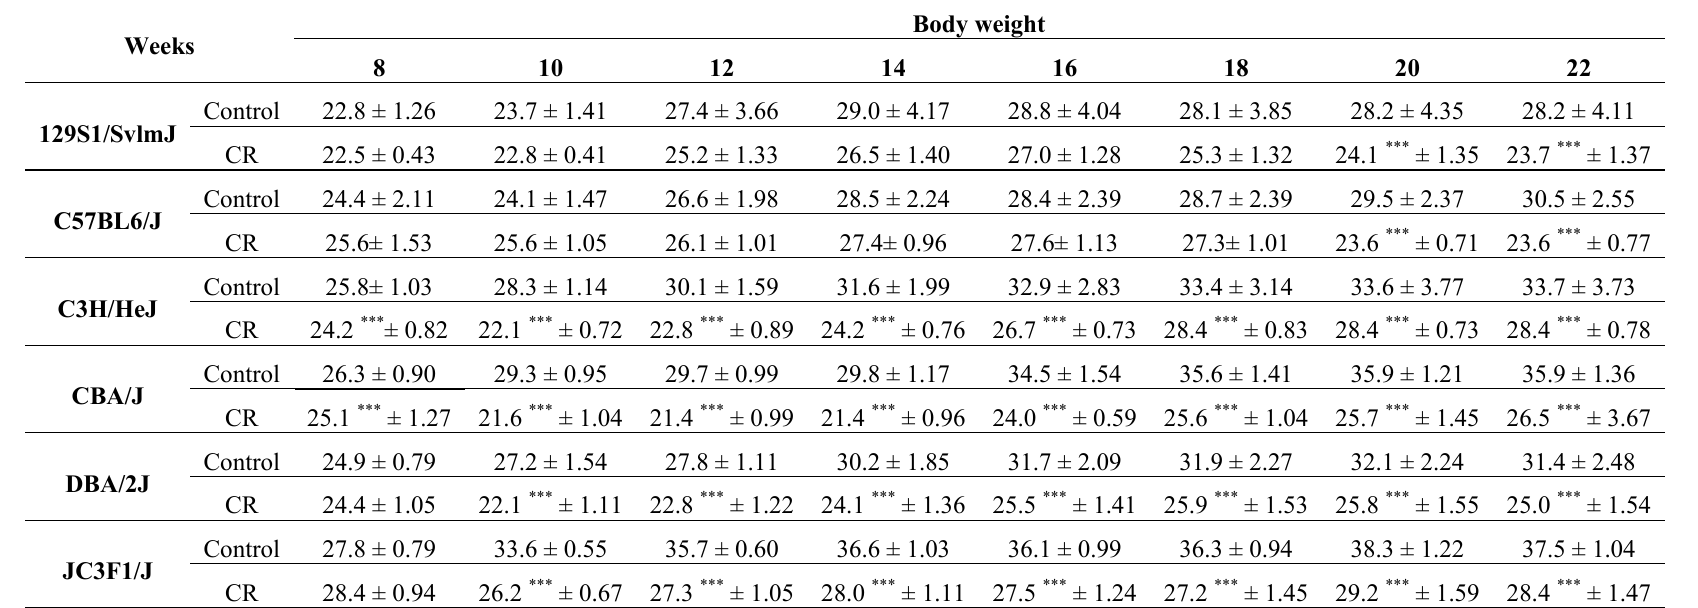
Table A1. Body weight for the control and CR strains. Data are reported as mean ± SE values for the body weight gain calculated from Week 8 onwards. Control and CR groups are plotted with dot and square shapes, respectively. Differences of body weight gain were statistically significant between CR and control group were tested by ANOVA and Bonferroni post-tests ( *** p < 0.001